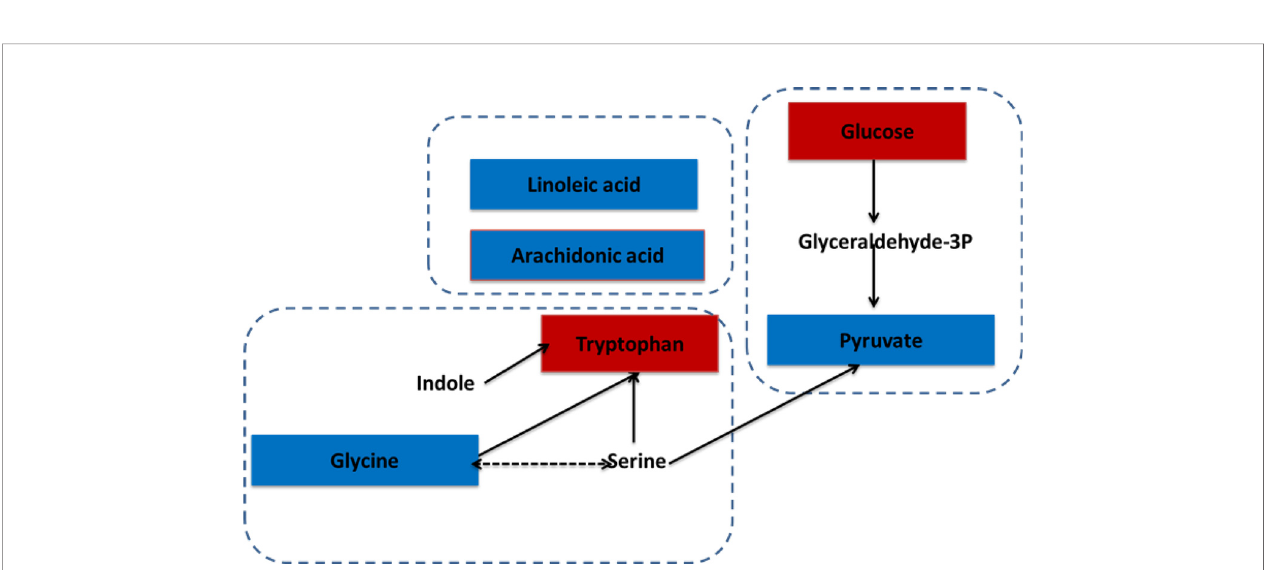
FIGURE 9 | The correlation between differential metabolites and gingivitis. The metabolites, which are marked red, indicating signi fi cantly increased in the gingivitis group. The blue marked metabolite indicates a